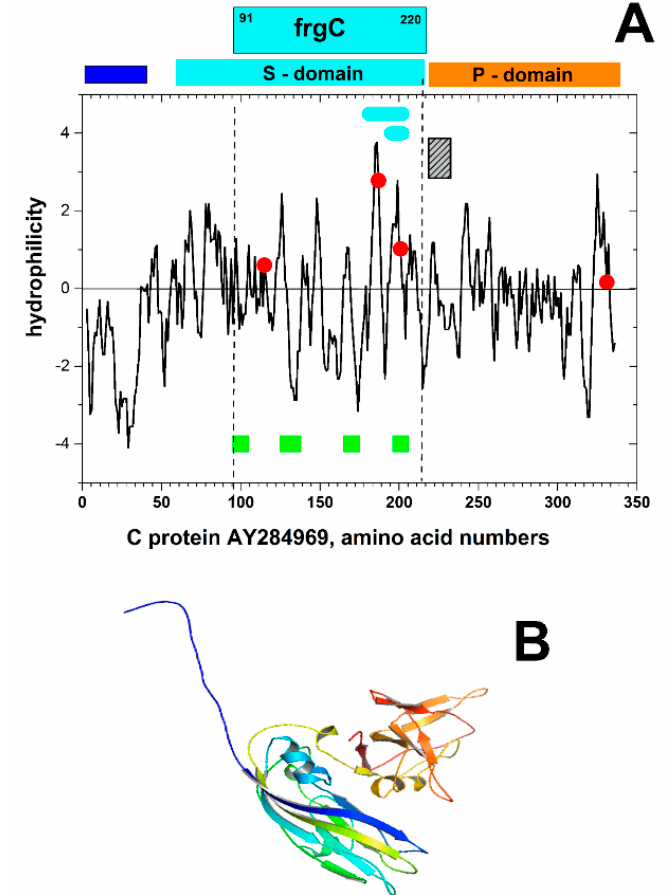
Figure 1. Scheme of the hydropathicity ( A ) and tridimensional structure ( B ) properties of frgC 91–220.